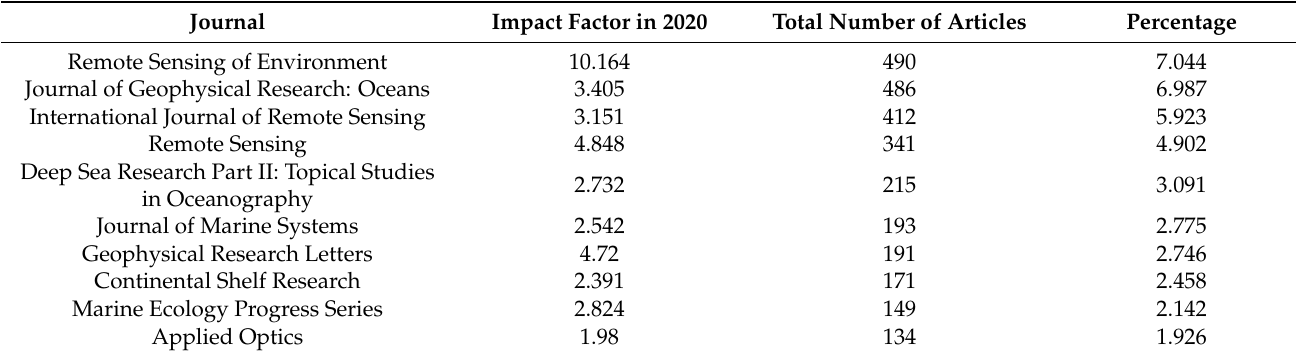
Table 2. The top 10 most productive journals and their impact factors in 2020, and the number and percentage of papers from 1990 to